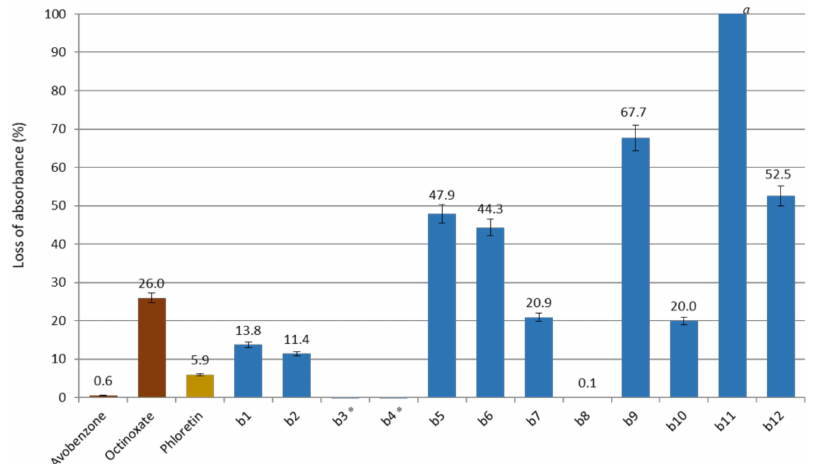
Figure 5. Loss of absorbance (in %) for dihydrochalcones series, phloretin and references avobenzone and octinoxate. a Full loss of absorbance. * Negative loss of absorbance (after 1 h of irradiation the absorbance was higher than at